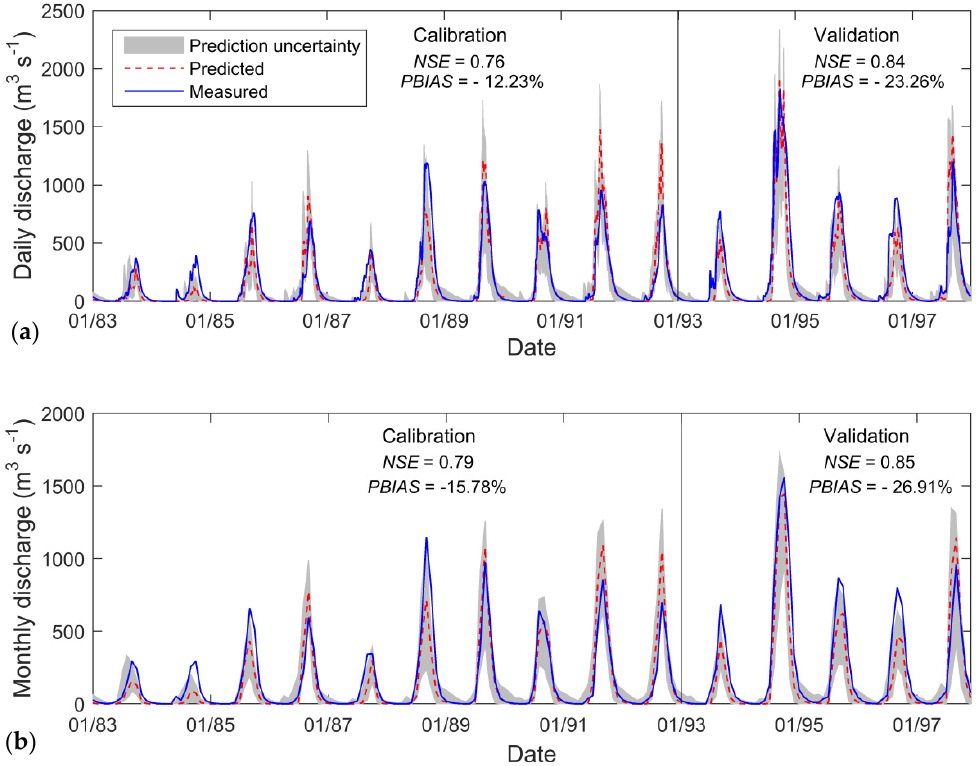
Figure 3. Simulated and observed hydrographs at Douna station at ( a ) daily and ( b ) monthly timesteps along with calculated statistics on calibration and validation periods.